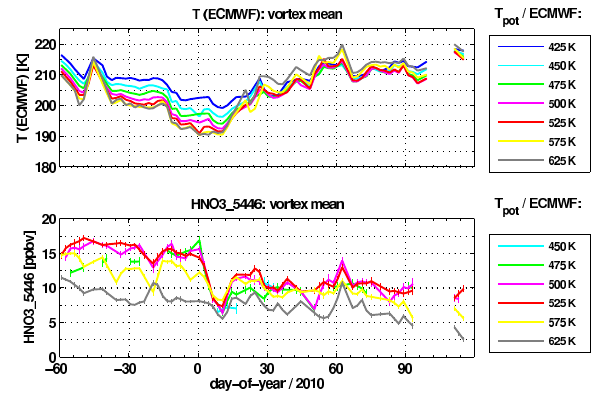
Fig. 2. Time series (vortex mean) of temperature derived from ECMWF (top) and HNO 3 (544.6GHz band) derived from Odin/SMR (bottom) during the Arctic winter